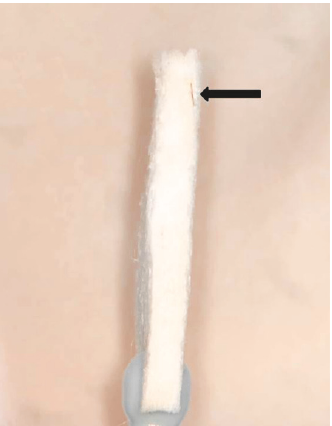
Figure 2: Clinical photo of the hair foreign body (black arrow) on a weck-cell following removal under local anesthetic with a microblade and jeweler’s